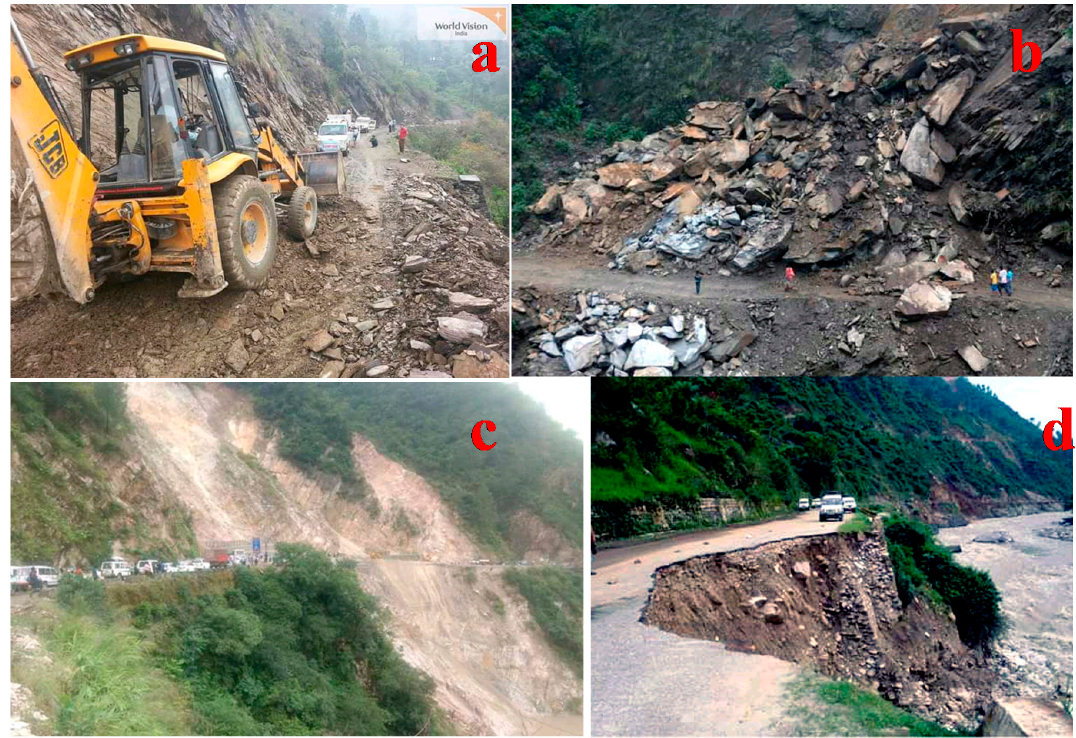
Figure 3. Field photographs showing some landslides in the study area: ( a ). Rudraprayag Gouri-kund